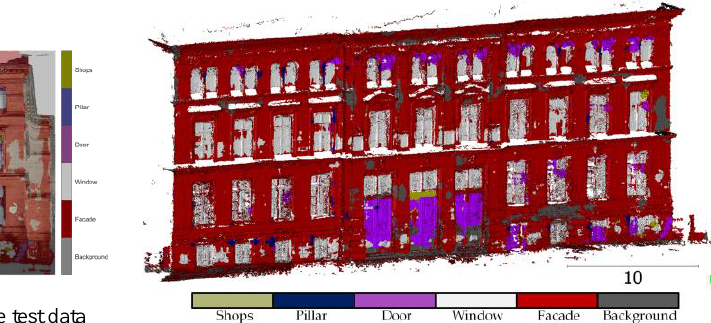
Figure 5. Result of the semantic segmentation on the test data superimposed on the original orthophoto.